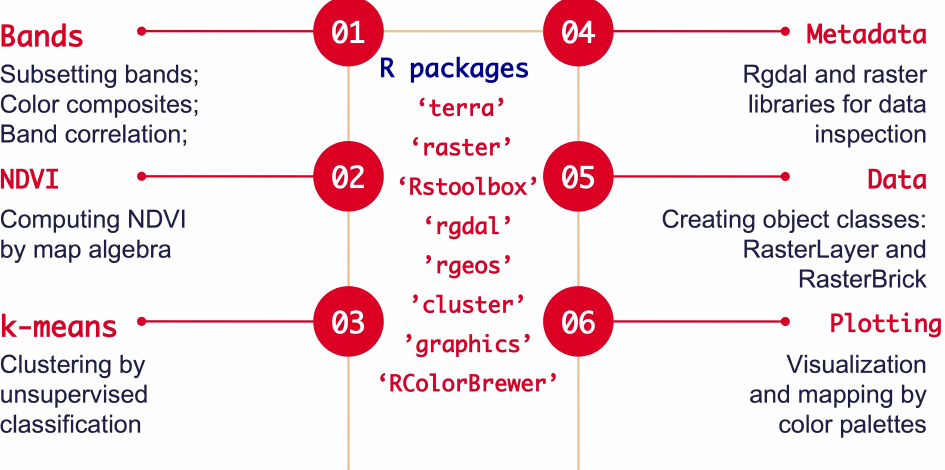
Figure 3. The functionality of R packages used for satellite image processing and classification in this study. Major packages include terra, raster, Rstoolbox, rgdal, rgeos, cluster, graphics, and RColorBrewer.